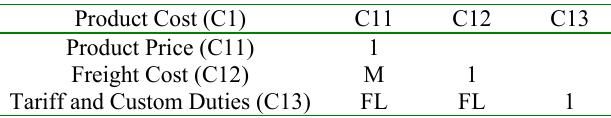
Table 5. Linguistic evaluation matrix of DM1 for C1 sub-criteria